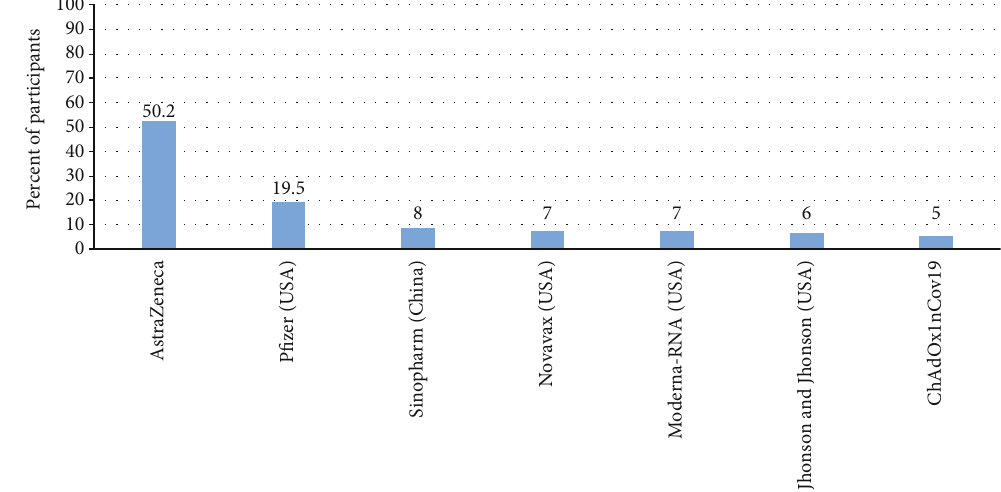
Figure 4: Types of vaccines accepted to be taken by the participants.